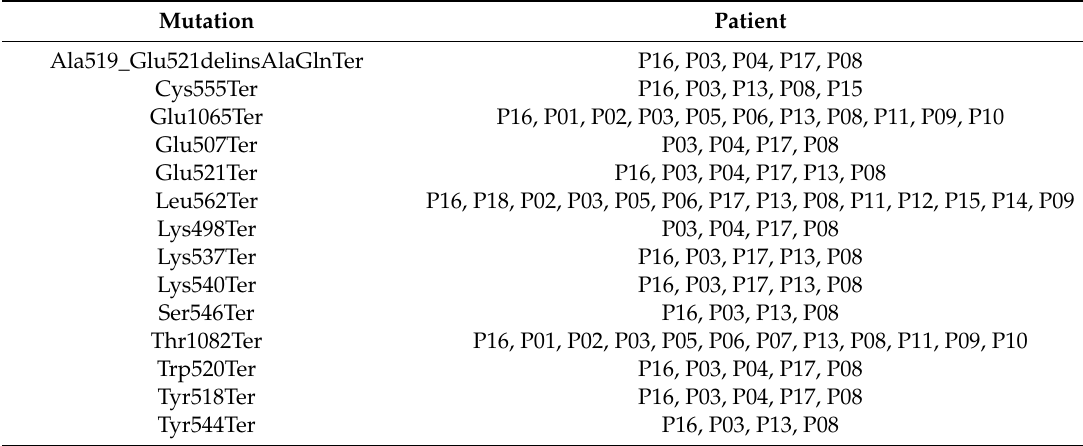
Table 2. Low frequent nonsense mutations in ABCC1